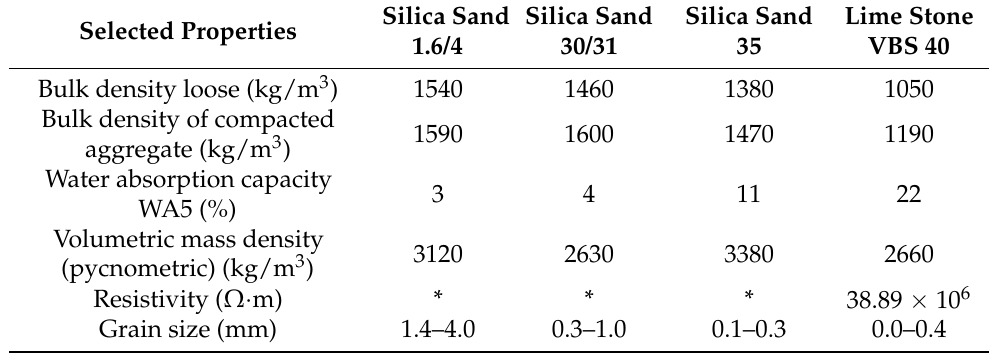
Table 2. Selected properties of